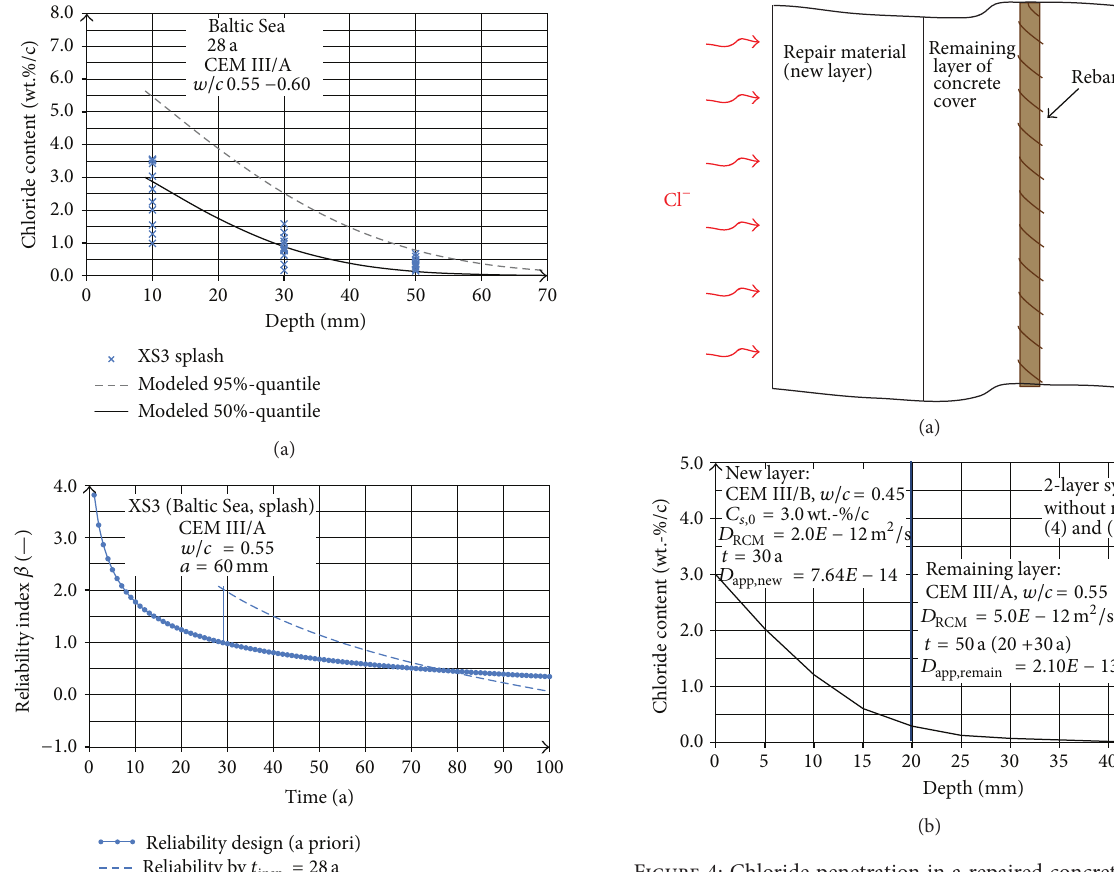
Figure 4: Chloride penetration in a repaired concrete element: 2- layer